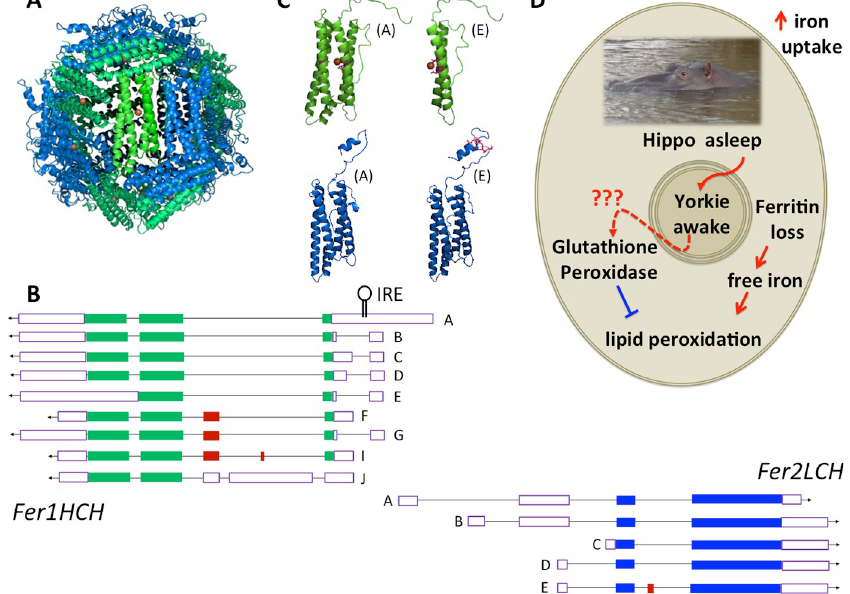
Fig 1. The Drosophila ferritin complex and its relationship to ferroptosis. ( A) Homology model of the assembled protein complex based on PDB: 1Z6O. Ferritin H subunit in green and L subunit in blue. (B) The genes encoding for H and L subunits are linked in a head-to-head orientation. Transcripts are taken from Flybase. ORFs for the ferritin H and L subunits are shown in green and blue, respectively. Red shows alternatively spliced ORFs. The position of an IRE is depicted. Note the H subunit isoform that lacks the leader peptide sequence and is therefore predicted to encode a cytosolic protein (transcript J). (C) Homology model structures for ferritin H subunit monomers resulting from transcripts A and E (green; amino acid side chains coordinating an iron atom at the ferroxidase site are shown) and ferritin L subunit monomers A and E (blue; amino acid side chains are shown for the short, additional N-terminal insertion in isoform E). (D) Simplified scheme showing a Drosophila wing cell that has survived ferroptosis or a cancer cell primed for ferroptosis. Iron misregulation is key to both, but whether GTPx-1 is involved in Drosophila (like GPx4 is in cancer cells) remains to be seen. Fer1HCH, Ferritin 1 heavy chain homolog; GTPx-1, Glutathione peroxidase homolog with thioredoxin peroxidase activity; IRE, iron-responsive element; ORF, open reading frame; PDB, protein data